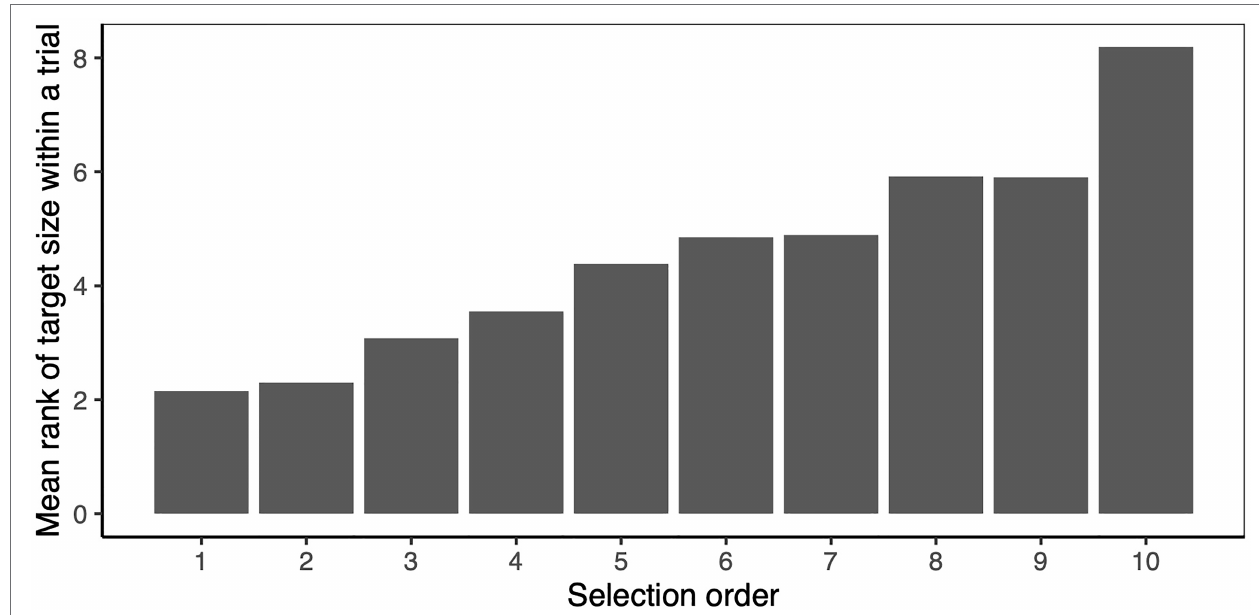
FIGURE 4 | Average ranked size of target instance by selection order for Experiment 1. Lower ranks indicate larger target instances in the